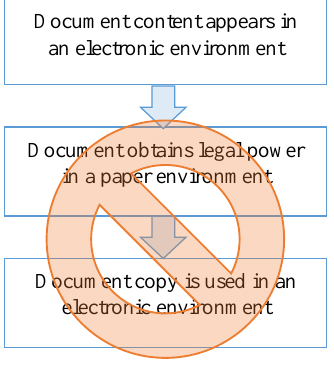
Fig. 1. Comparison of two ways of document